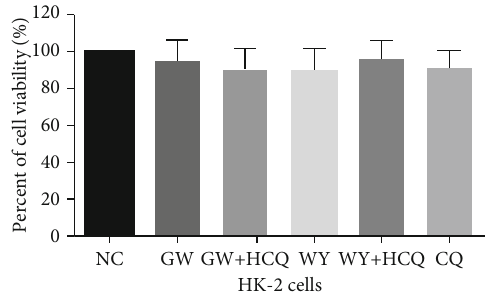
Figure 6: On cotreatment of GW6471 and hydroxychloroquine, the HK-2 cells showed no signi fi cant e ff ect on cell viability. ( n = 3 , CCK-8